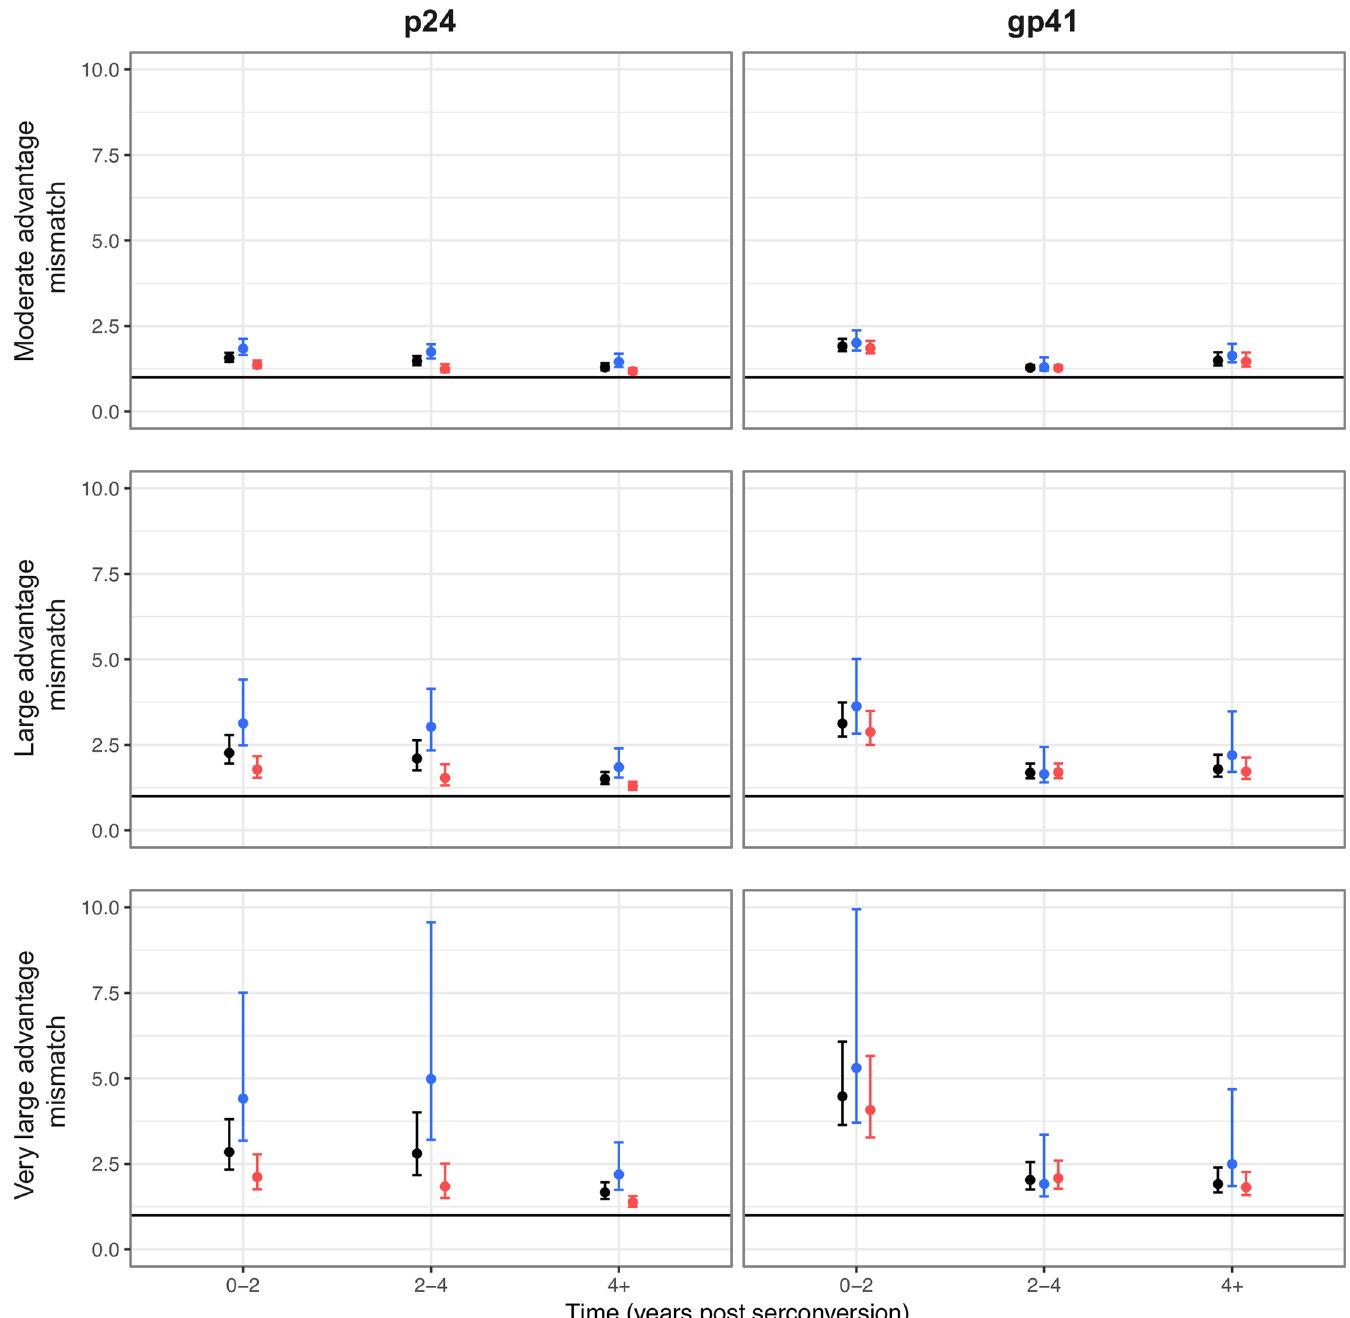
Fig 4. Contribution to the mismatch in evolutionary rates if founder-like virus has a transmission advantage. Each point represents the mean contribution of the 34 individuals to the mismatch in phylogenetic rates if transmission occurs during the given time period, and where each viral sequence has a transmission fitness w d = e − α d . The contribution to the mismatch for each sampling time point for each individual was calculated as the ratio of the mean number of mutations from the founder population, μ , to the expected mean distance of transmitted virus from the founder population, μT , giving m = μ / μT .A mismatch of 1 therefore indicates the case where the within- and between-host rates of evolution are expected to be the same. We show results for a moderate ( α = 1), large ( α = 2), and very large ( α = 3) transmission advantage. The error bars give the 5 and 95 percentiles from bootstrapping over the individuals 100,000 times. Black, all mutations; Blue, only synonymous mutations are considered when calculating the expected mismatch; Red, only nonsynonymous mutations are considered when calculating the expected mismatch (see Methods).